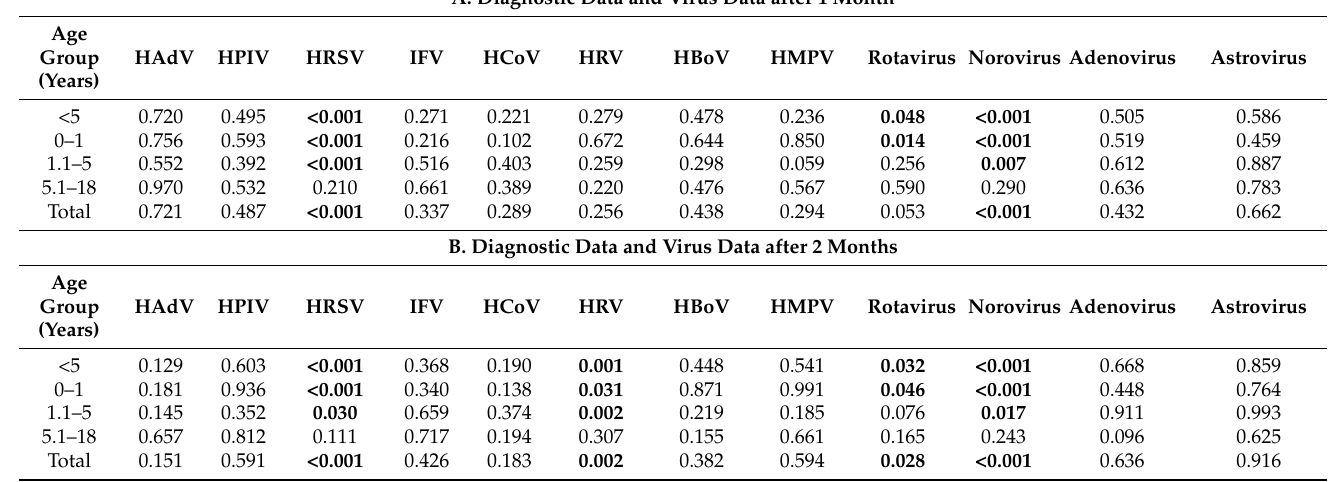
Table 4. Values of the Granger causality test between the time series of Kawasaki disease diagnosis and the time points of positive detection rates of virus, with <0.05 indicating significance (written in